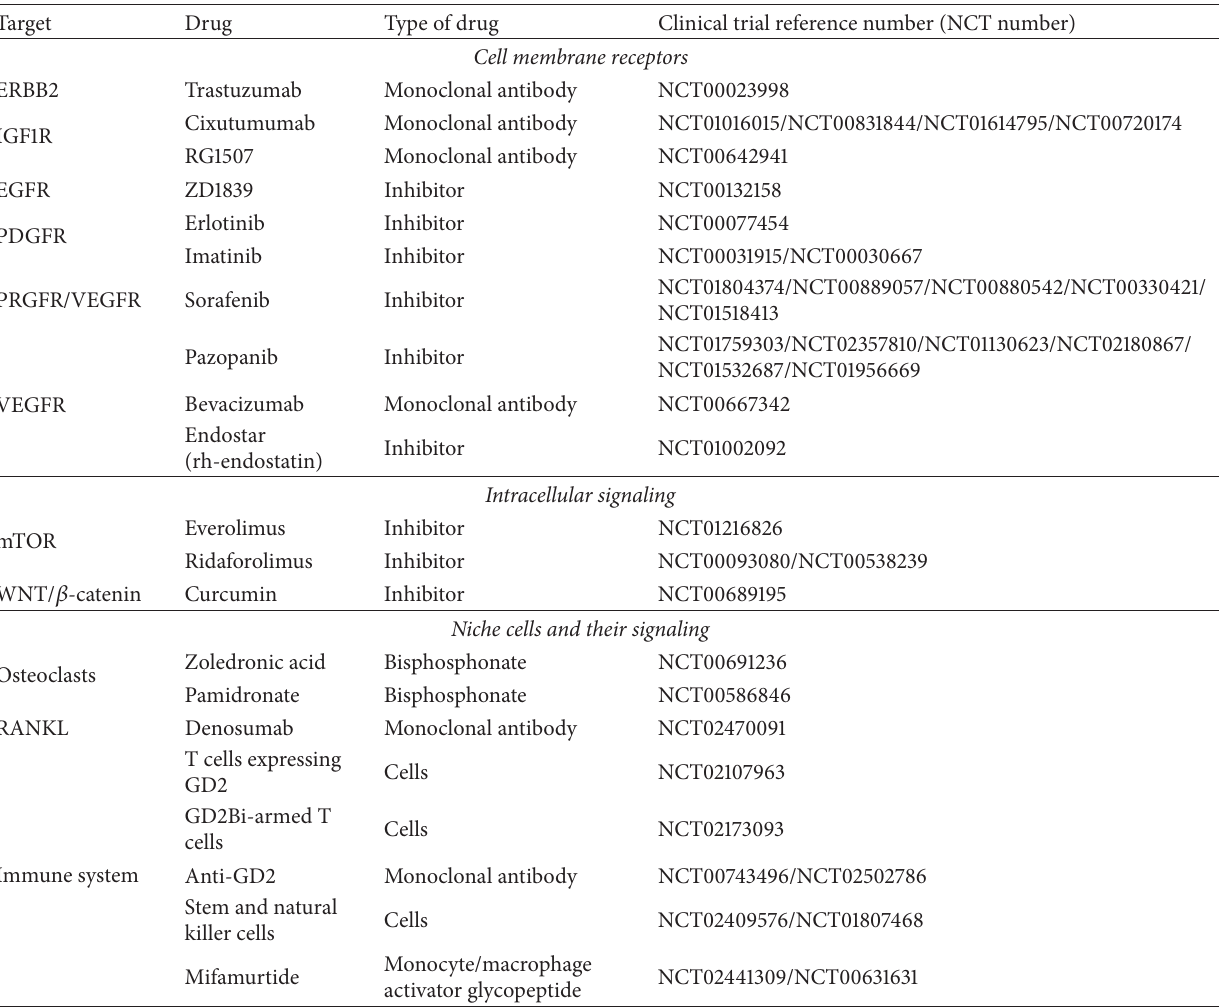
Table 1: Selected clinical trials targeting altered signaling and tumor environment in OS ∗